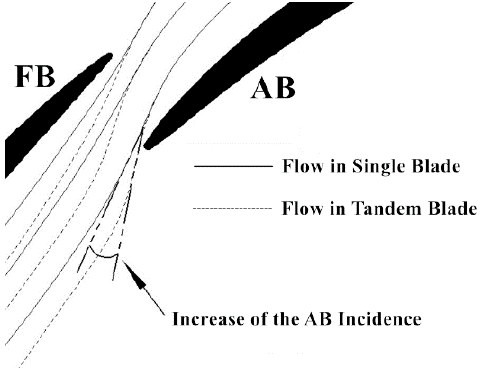
Appl. Sci. 2020 , 10 , x FOR PEER REVIEW Figure 11. Tandem blade gap flow detail. Figure 11. Tandem blade gap flow detail. Figure 11. Tandem blade gap flow detail.